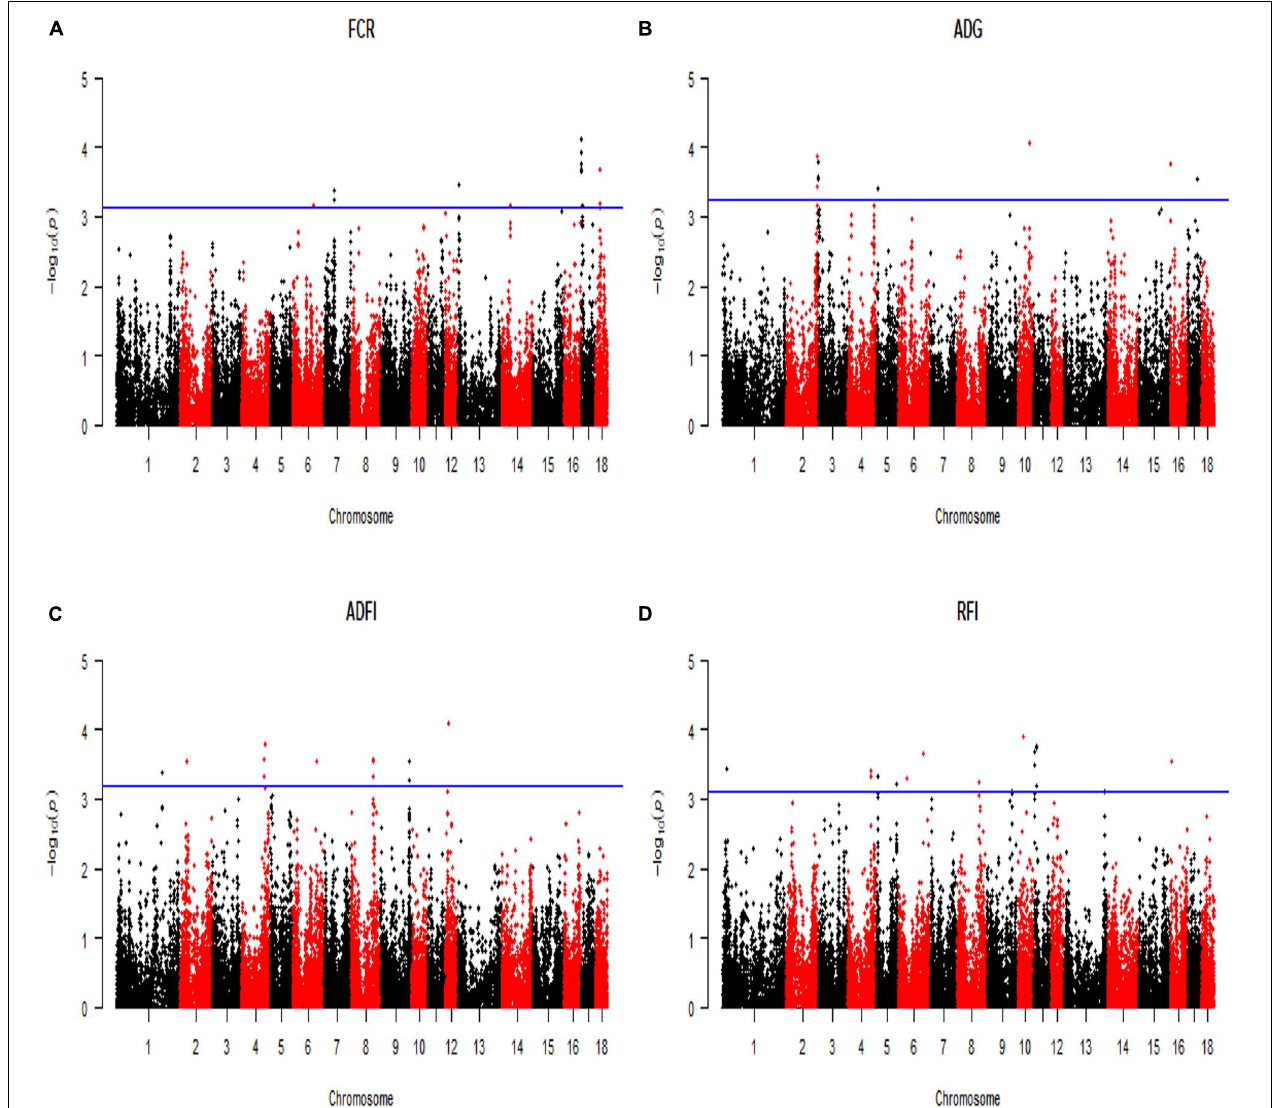
FIGURE 2 | Manhattan plot of the genome-wide association analysis on four feed efficiency traits by using linear model GWAS (LM-GWAS) method. FCR, Feed conversion ratio; ADG, Average daily gain; ADFI, Average daily feed intake; RFI, Residual feed intake. In the Manhattan plots, negative log10 P- values of the quantified SNPs were plotted against their genomic positions. The x -axis and the y -axis represent the number of chromosome and the observed -log 10 ( P -value), respectively. Different colors indicate various chromosomes. The blue lines indicate the genome-wide significant thresholds of FDR adjusted, respectively. For (A) FCR, it was 7.48 × 10 − 4 . Similarly, (B) ADG was 5.64 × 10 − 4 , (C) ADFI was 6.53 × 10 − 4 , and (D) RFI was 7.58 × 10 − 4